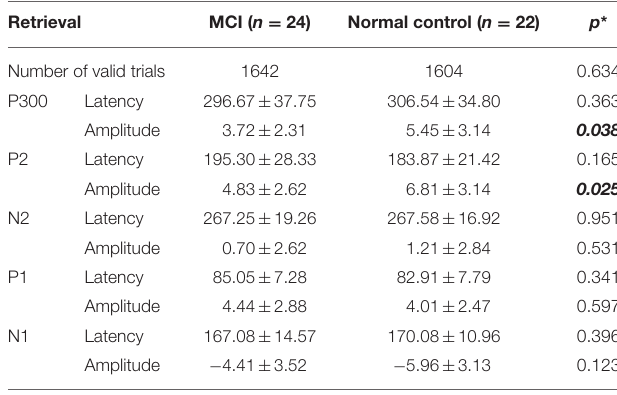
TABLE 2 | Parameters of ERP component in encoding epoch (Mean ± Standard deviation).